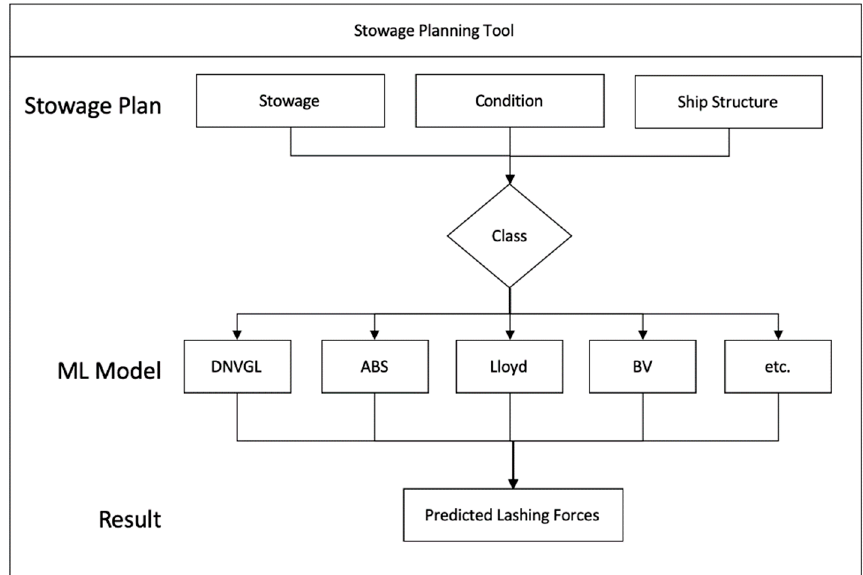
Figure 3. Illustration of idea.